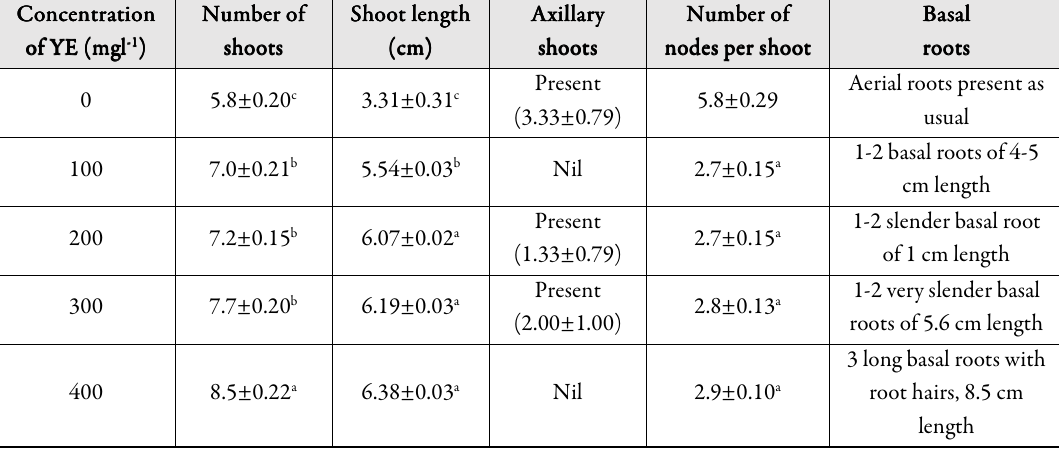
Table 2. Effect of yeast extract (YE) on shoot multiplication of C. nutans Concentration Number of of YE (mgl -1 )